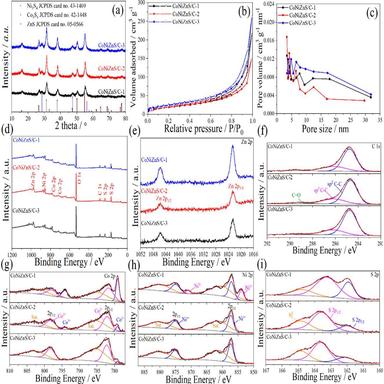
(a) XRD patterns of CoNiZnS/C-1, CoNiZnS/C-2 and CoNiZnS/C-3. (b) N2 adsorption-desorption isotherms and (c) pore size distributions of CoNiZnS/C-1, CoNiZnS/C-2 and CoNiZnS/C-3. (d) XPS survey spectra of CoNiZnS/C-1, CoNiZnS/C-2 and CoNiZnS/C-3. High-resolution XPS spectra of (e) Zn 2p, (f) C 1s, (g) Co 2p, (h) Ni 2p and (i) S 2p for CoNiZnS/C-1, CoNiZnS/C-2 and CoNiZnS/C-3.